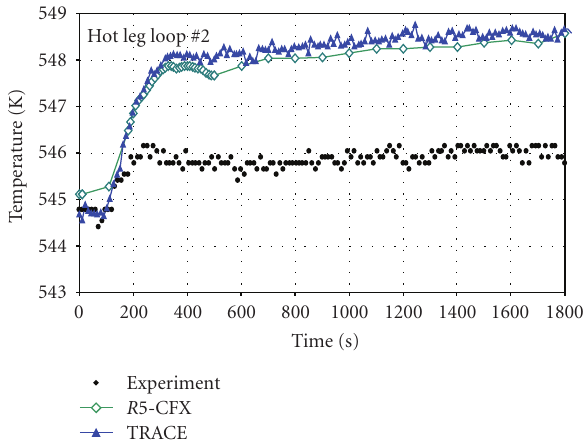
Figure 20: Comparison of the data with the predictions for loop 2.